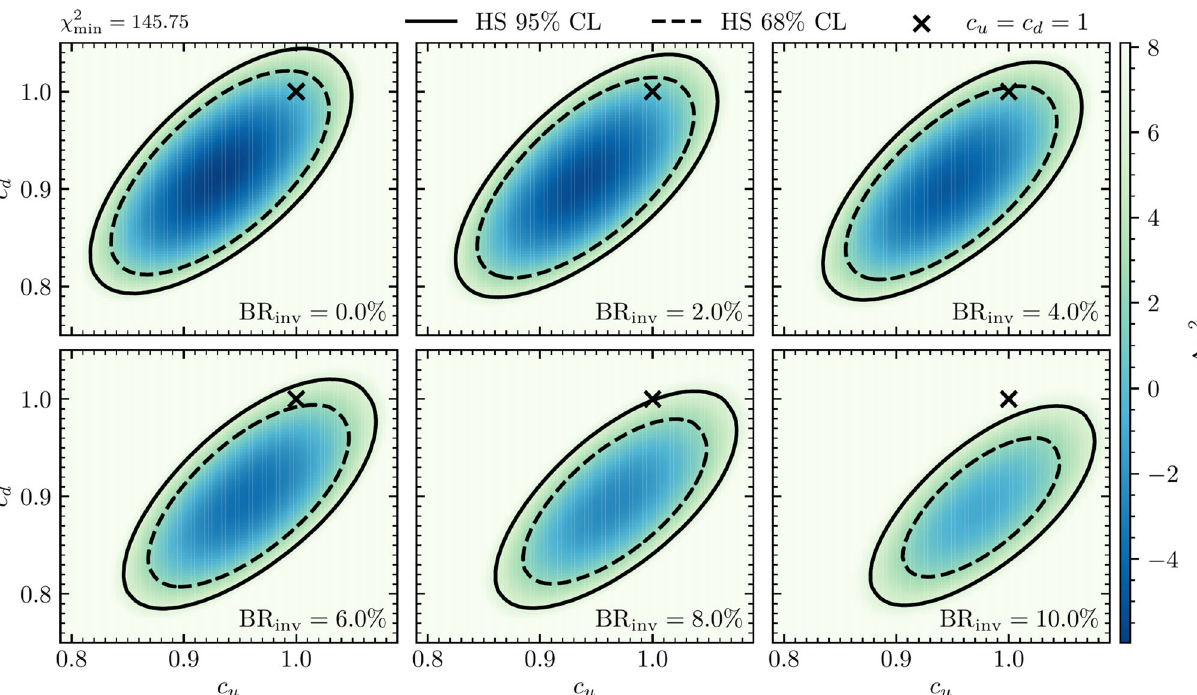
Fig. 4 As Fig. 3, but in the plane { c u , c d } and assuming that c (cid:9) = c d and c V =